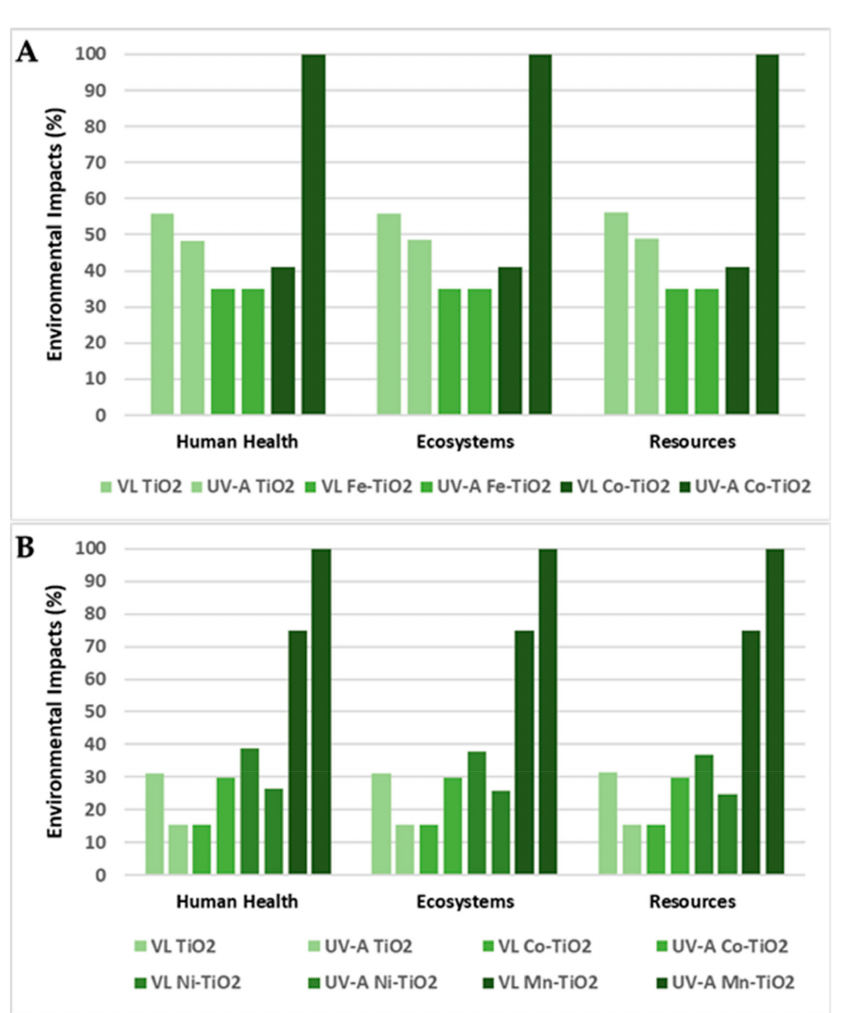
Figure 3. Relative environmental impacts of di ff erent TiO 2 photocatalysts synthesis for CBZ ( A ) and MO ( B ), considering photocatalytic activity as a functional unit, under either UV-A or visible-light (VL)